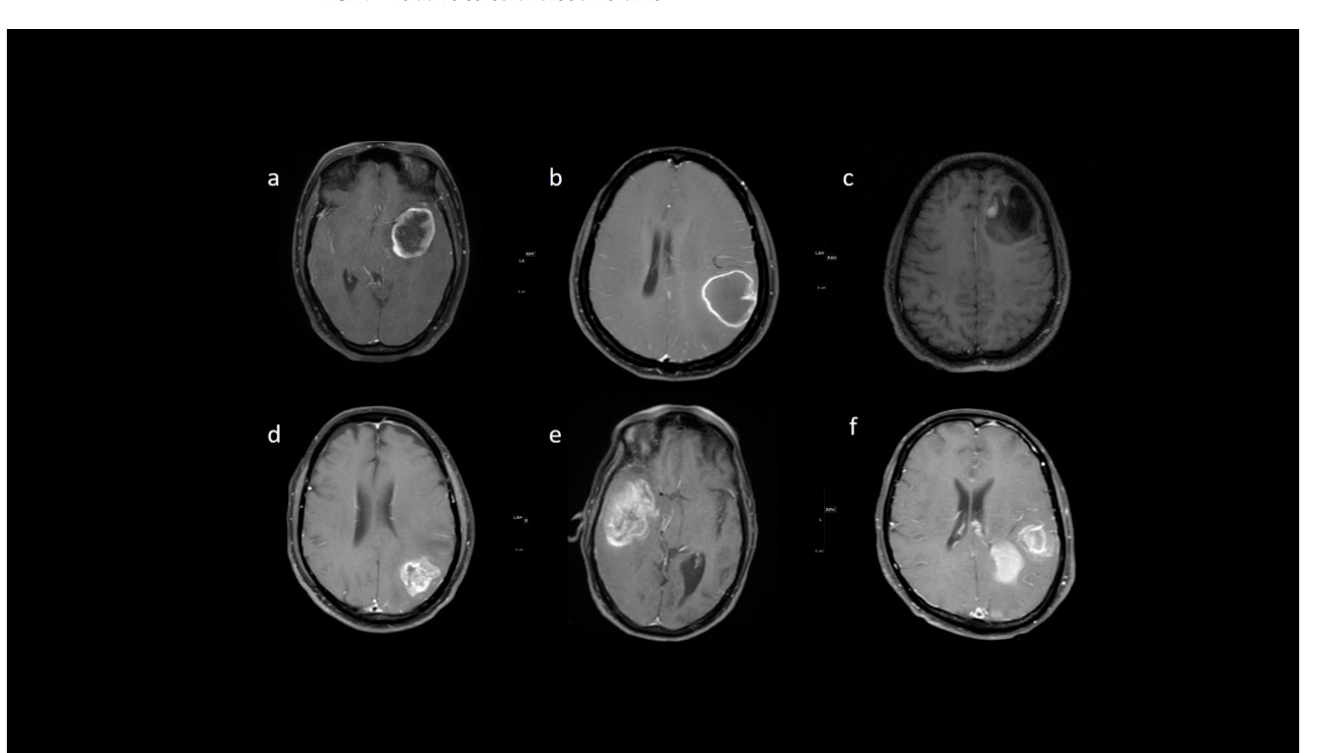
Figure 8. ( a – e ) Representative post-contrast T1 images showing various enhancement patterns: ( a ) no noticeable enhancement; ( b , c ) severe enhancement, ( d ) moderate enhancement pattern, and ( e ) mild enhancement.